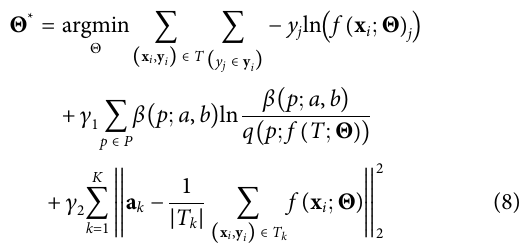
Frontiers in Arti fi cial Intelligence |